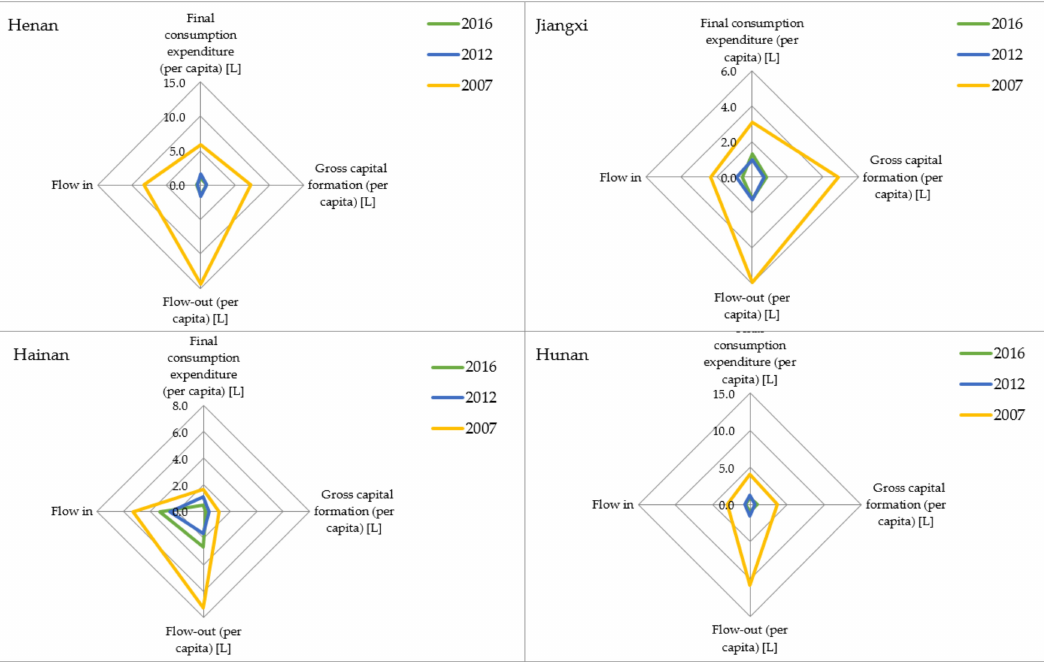
Figure A1. Changes of four indicators in 2007, 2012 and 2016 of Group 1.